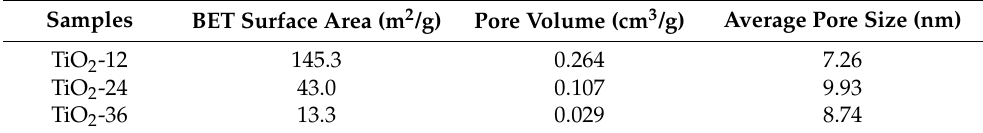
Figure 4. Nitrogen adsorption–desorption isotherms and pore size distribution curves of samples: ( a ) TiO 2 -12 h, ( b ) TiO 2 -24 h and ( c ) TiO 2 -36 h. Table 1. Textural properties of